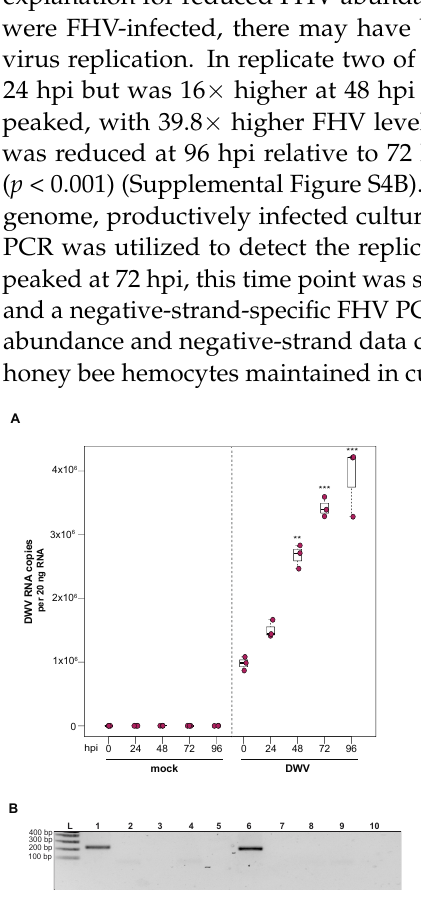
Figure 3. Deformed wing virus (DWV) replicates in primary honey bee pupal cell cultures. DWV abundance was assessed in mock- or DWV-infected pupal cells via qPCR over a time course (i.e., 0 hpi, 24 hpi, 48 hpi, 72 hpi, and 96 hpi). ( A ) Pupal cells infected with 4.3 × 10 6 DWV RNA copies had a 2.7× ( p < 0.001) and 3.5× ( p < 0.001) increase in mean DWV abundance at 48 hpi and 72 hpi, respec- tively, relative to 0 hpi. At 96 hpi, mean DWV abundance was 4× higher relative to 0 hpi ( p < 0.001). Figure 3 includes results from one representative biological replicate. The data for additional repli- cates are presented in Supplemental Figure S3. All differences in means relative to 0 hpi were as- sessed by a Dunnett’s test. Raw data are included in Supplemental Table S4. Significance levels: ** p < 0.005; *** p < 0.0005. ( B ) To verify DWV replication in purple-eyed pupal cells, negative-strand- specific RT-PCR was performed, and the replicative intermediate form (i.e., negative strand) of DWV was detected at 72 hpi. Additional control reactions were performed using pooled RNA from time points 24–96 hpi (Lanes labeled 2–9). Specifically, RNA isolated DWV containing cell lysate was reverse-transcribed with the primer listed below, treated with Exonuclease I to remove excess primer, and amplified using the PCR primers listed for each lane. (L) Molecular weight ladder. (1) 72 hpi RNA template—RT with DWV-TAGS-F, PCR with TAGS and DWV-Rev. (2) Negative con- trol: No RT in the presence of (DWV-TAGS-F), PCR with TAGS and DWV-Rev. (3) Negative control: RT in the presence of (DWV-TAGS-F), PCR with only the DWV-Rev primer. (4) Negative control: RT with random hexamer primer, PCR with TAGS and DWV-Rev. (5) Negative control: No RT en- zyme in the presence of random hexamers, PCR with DWV-F and DWV-Rev. (6) Positive control: RT with random hexamers, PCR with DWV-F and DWV-Rev. (7) Negative control: RT with random hexamers, PCR with only DWV-Rev primer. (8) Self-priming: RT without a primer, PCR with DWV- F and DWV-Rev (9) Negative control: No template, no RT, PCR with TAGS and DWV-Rev. (10) Negative control: No template, no RT, PCR with DWV-F and DWV-Rev. Additional details pro- vided in Supplemental Table S25.